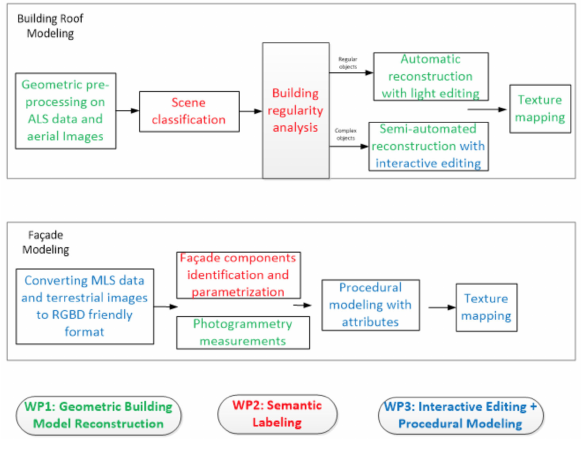
Figure 1. Interaction of work packages